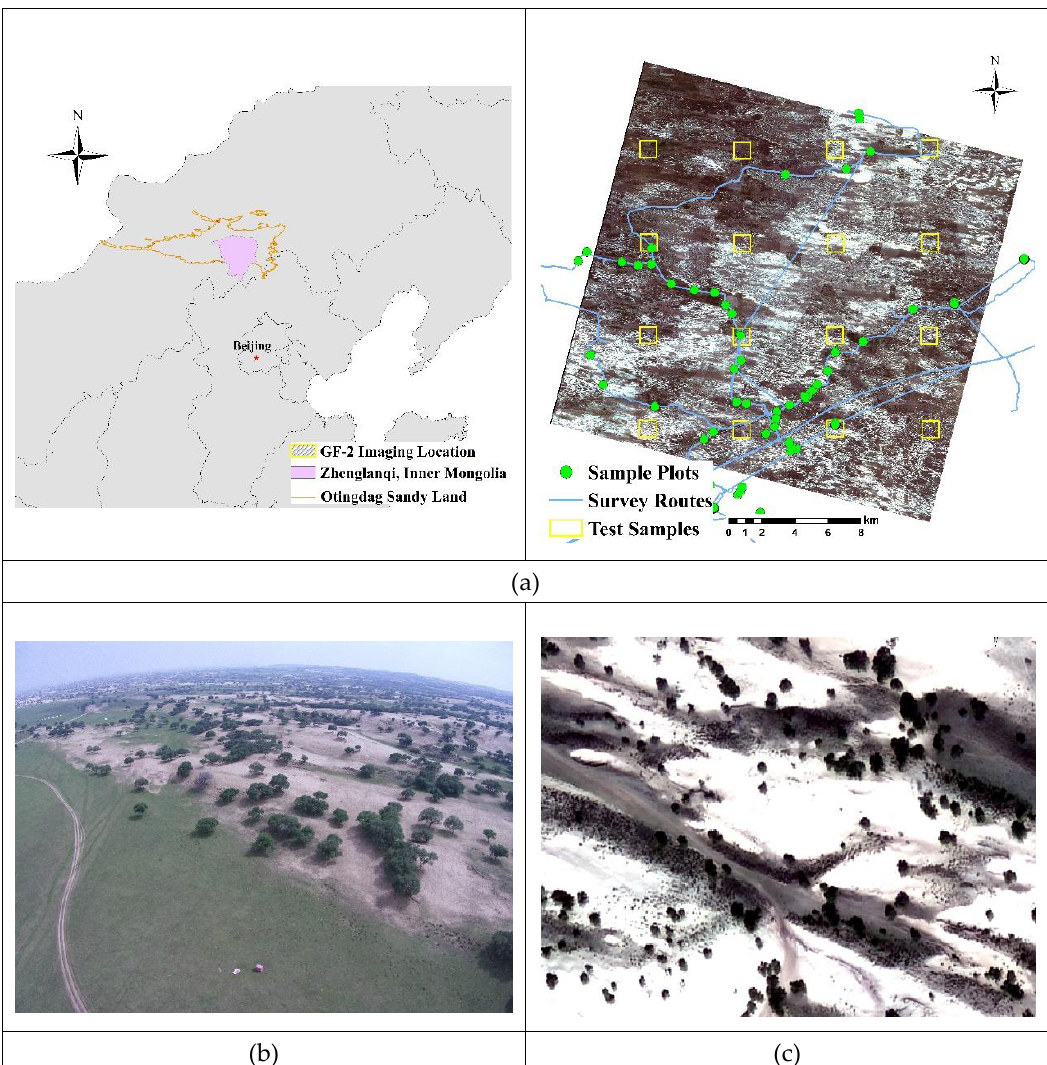
Figure 1. Typical Ulmus pumila landscape and field survey in the study area. (a) Study area, GF-2 imaging location and field survey; (b) Ulmus pumila landscape in the hinterland of the Otingdag Sandy Land captured by an unmanned aerial vehicle; and (c) Ulmus pumila landscape in GF-2 imagery (fused image, 1-m resolution).